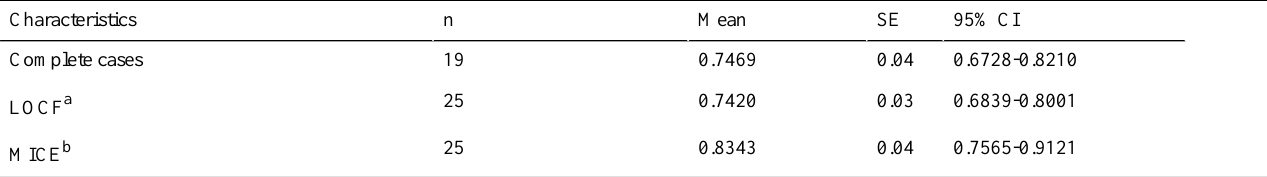
Table 6. Quality-adjusted life years at 12 months after videoconference-delivered cognitive behavioral